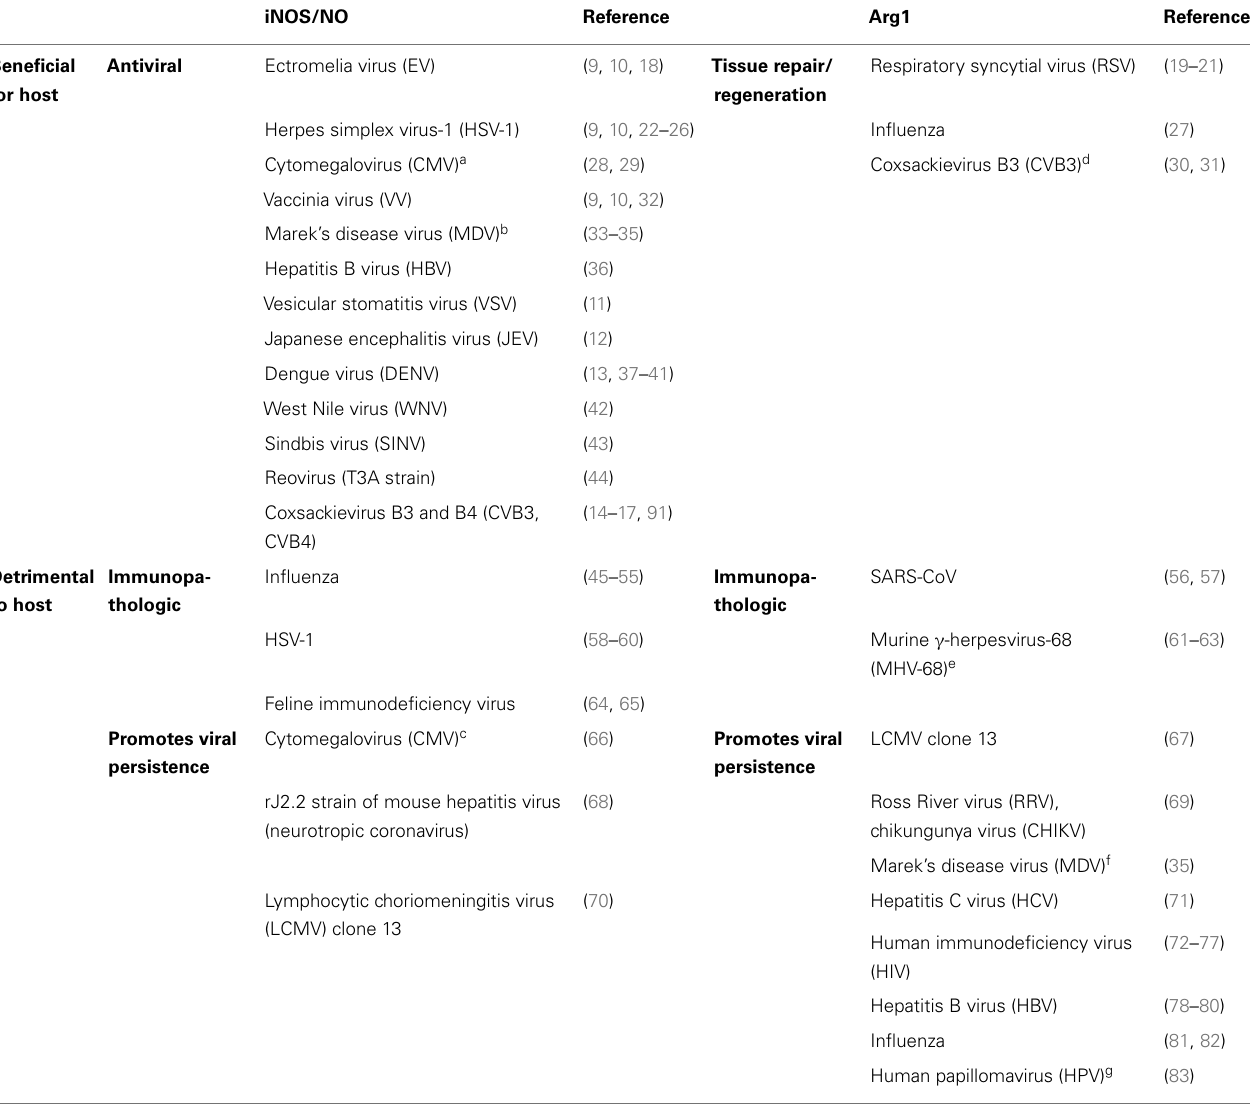
Table 1 | Differential roles for the L -arginine-hydrolyzing enzymes iNOS andArgl in virus-induced diseases